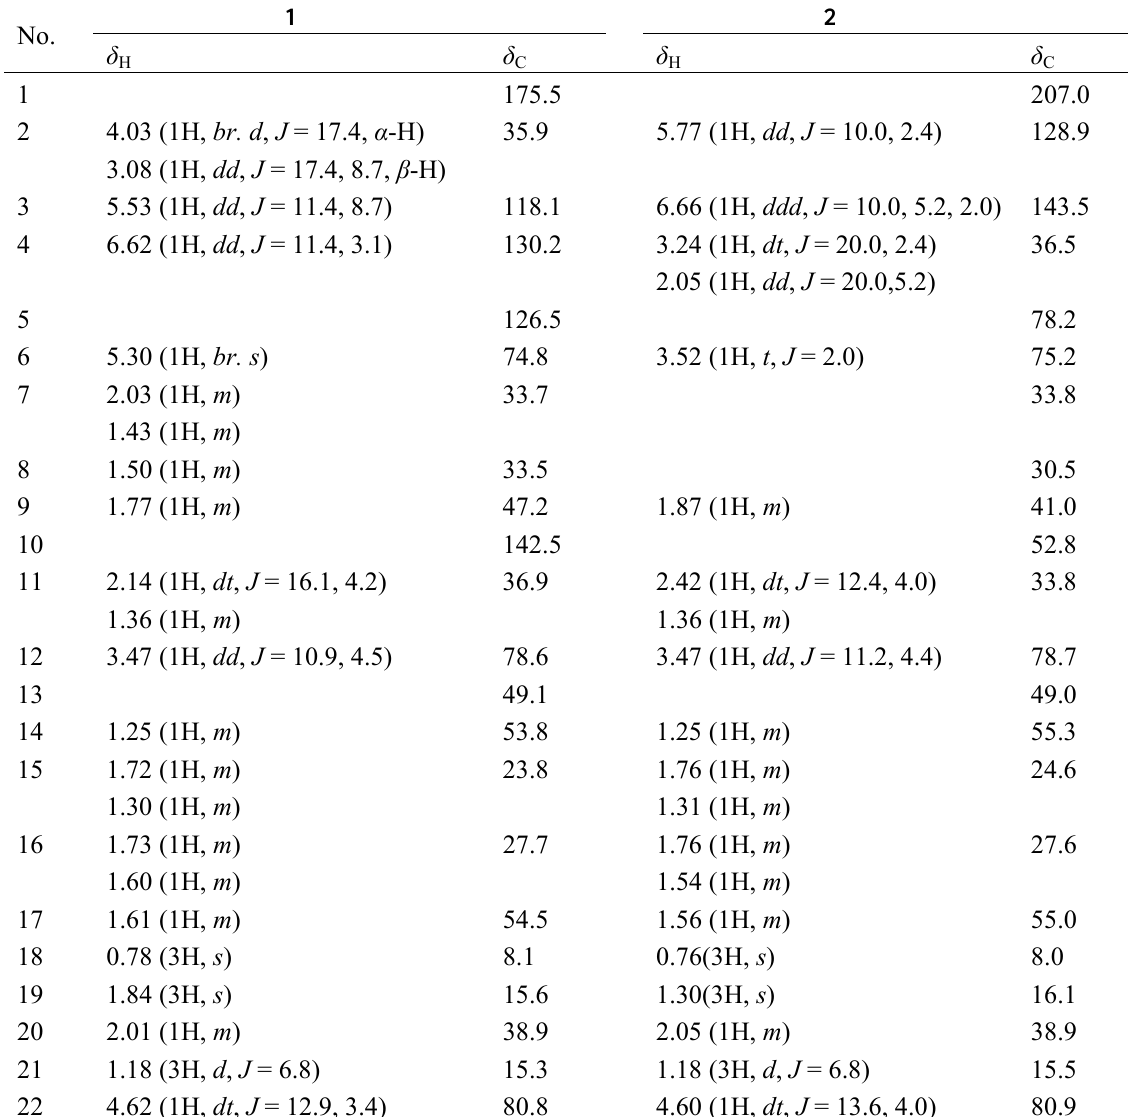
OD at 400 MHz and 100 MHz, J in 3